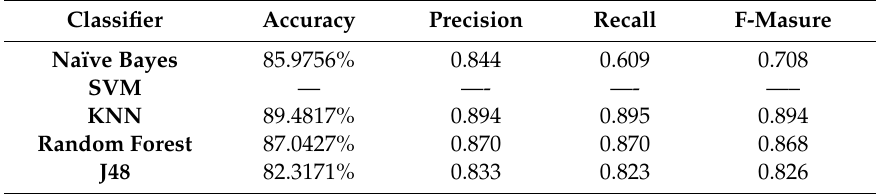
Table 4. Performance metrics for all TX–RX as di ff erent cases (632 features per case).